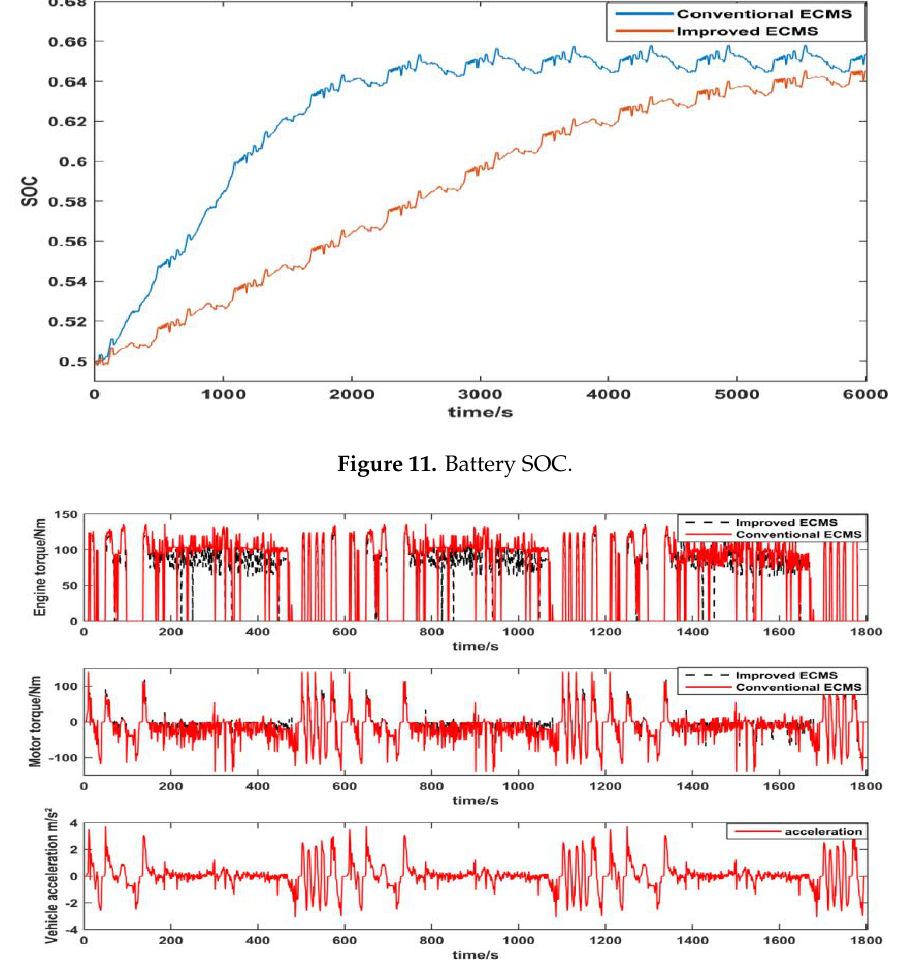
Figure 12. Engine and motor torque.